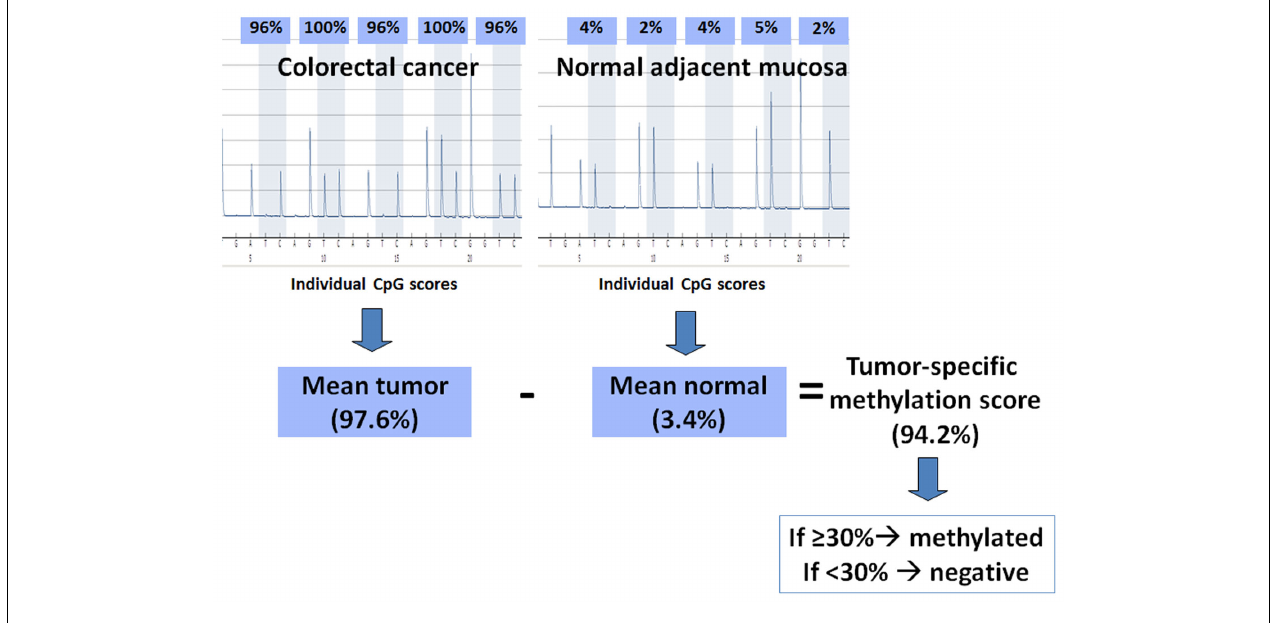
normal tissue is subtracted from the mean percent methylation of the tumor to give a tumor-specific methylation score. If this final score is ≥ 30%, then the tumor is considered methylated, otherwise it is considered negative for methylation.